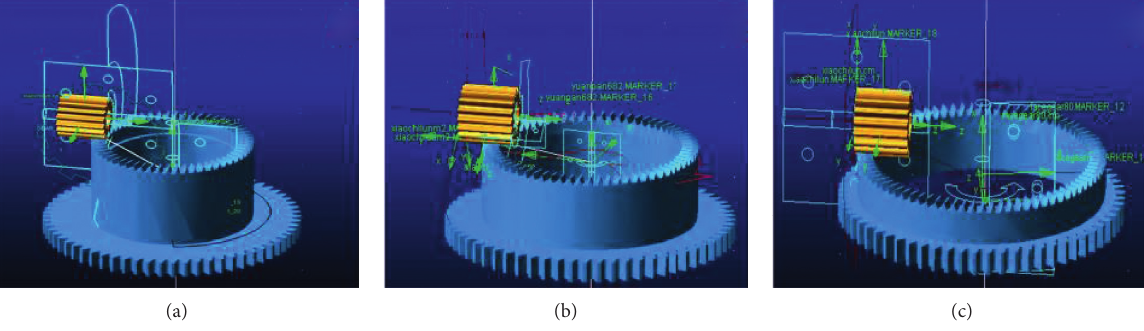
Figure 7: Dynamic model of single-stage face gear in